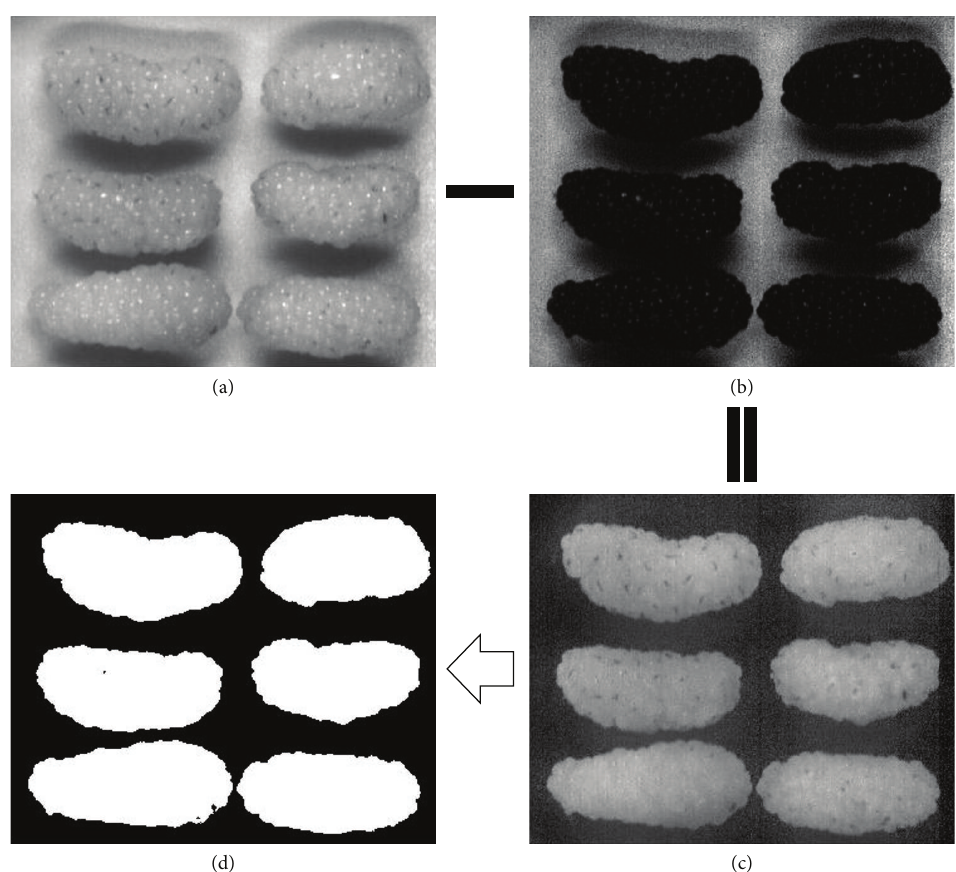
Figure 2: Details of acquiring mask (a) gray image at 893 nm; (b) gray image at 569 nm; (c) imsubtract result of (a) and (b); (d) mask image.